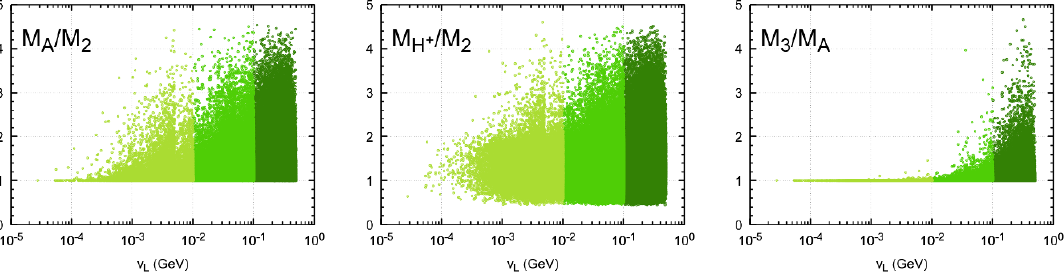
Figure 5 . Correlation between M A =M 2 (left), M H + =M 2 (middle), M 3 =M A (right) and v L . The color code as in (cid:12)gure 2. See text for